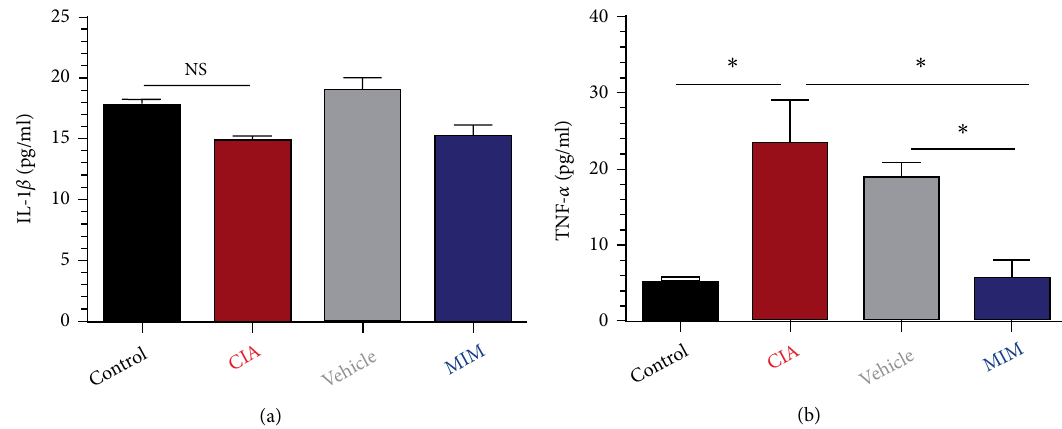
Figure 5: Inflammatory cytokines levels in plasma analyzed by ELISA. The optical density of each sample was measured at 450 nm, using the microplate reader TECAN. (a) IL-1- β levels (pg/ml), and (b) TNF- α levels (pg/ml) are represented in graphs, ∗ 푃 < 0.05 .